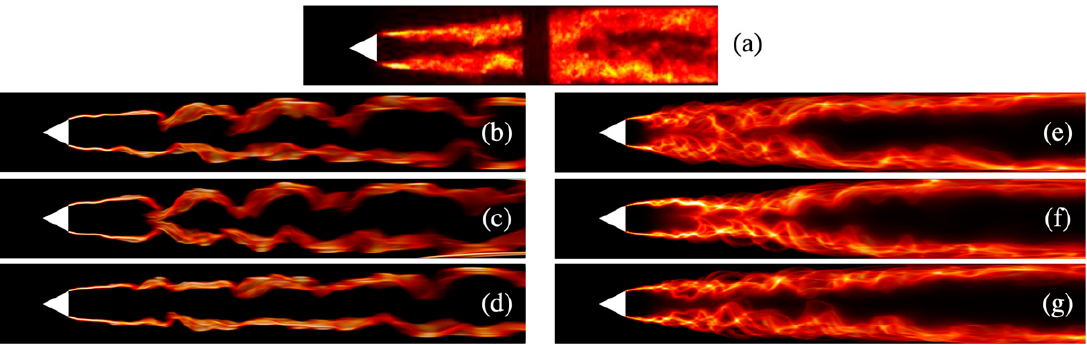
Figure 5. OH* chemiluminescence images from ( a ) experiments with n-dodecane, and from flamelet LES, using the FSD model of Weller et al. [28] of ( b ) n-dodecane, ( c ) Jet A, and ( d ) C1, and from LES-LDKM-EDC model of ( e ) n-dodecane, ( f ) Jet A, and ( g ) C1 at φ = 0.66.